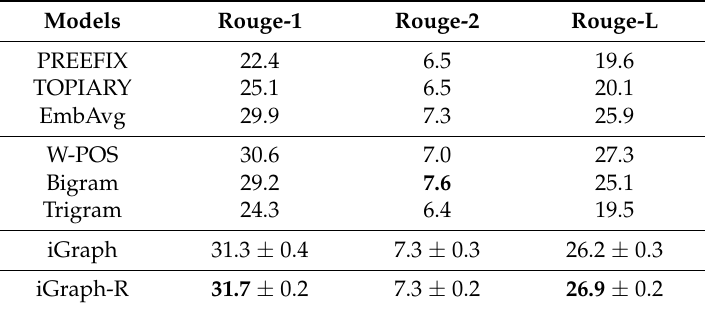
Table 3. The performance of various models on DUC 2004 using the limited length recall variants of Rouge at 75